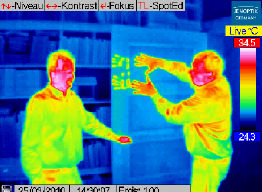
Figure 1: Visualization of the data captured with an InfraTec Var- ioCAM hr.